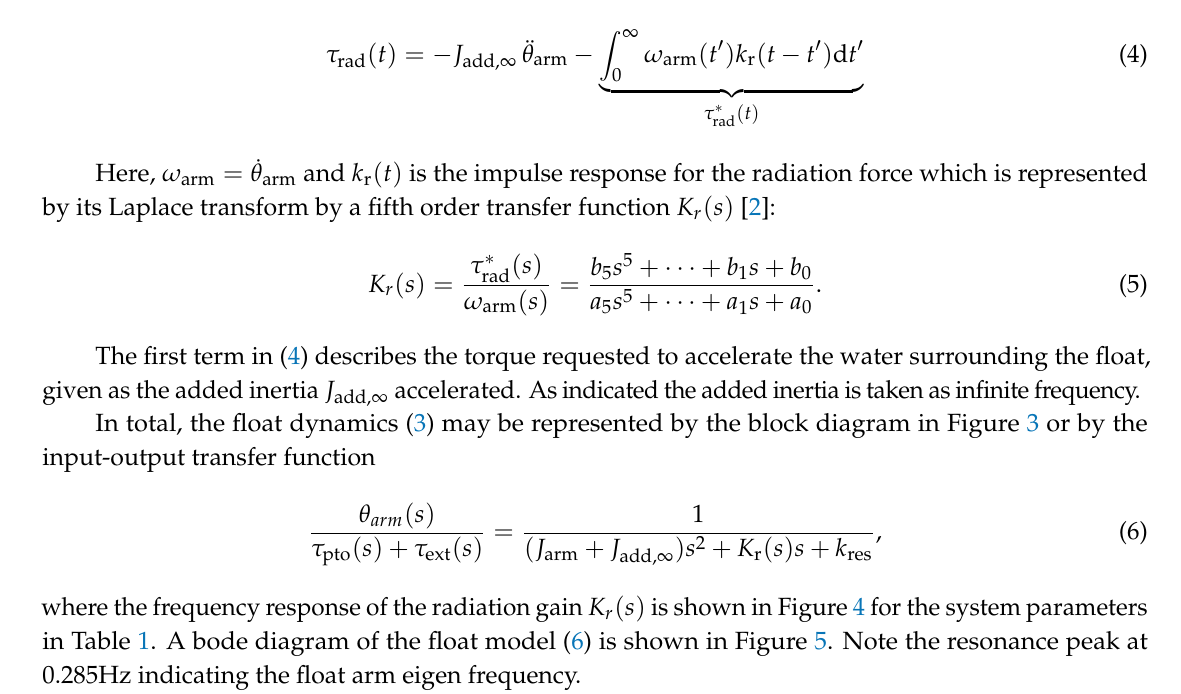
Table 2. Discrete PTO system parameters. The sign of the areas indicates the force direction. Chamber areas